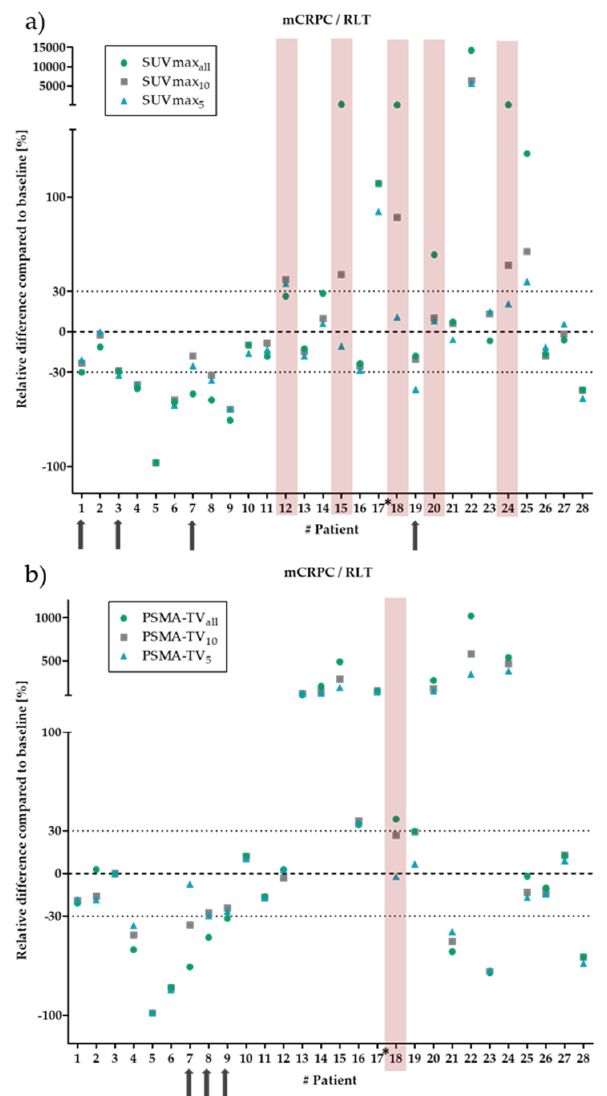
Figure 3. Relative changes between baseline and follow-up for SUV max ( a ) and PSMA-TV ( b ) in patients with metastatic castration-resistant prostate cancer (mCRPC) undergoing radioligand therapy (RLT). The green dots show the changes for all segmented lesions. The grey squares/blue triangles show the ten/five hottest lesions for SUV max and the ten/five largest lesions for PSMA-TV. The dotted lines mark the borders, which are considered as clinically relevant (±30%). The red bars mark patients with a clinically relevant deviation. For SUV max , 5 of the 28 patients showed a clinically relevant deviation. For PSMA-TV, only 1 of the 28 patients showed a relevant deviation. The black arrows indicate clinically non-relevant deviations in four patients for SUV max and three patients for PSMA-TV. The asterisks mark the patients with less than five